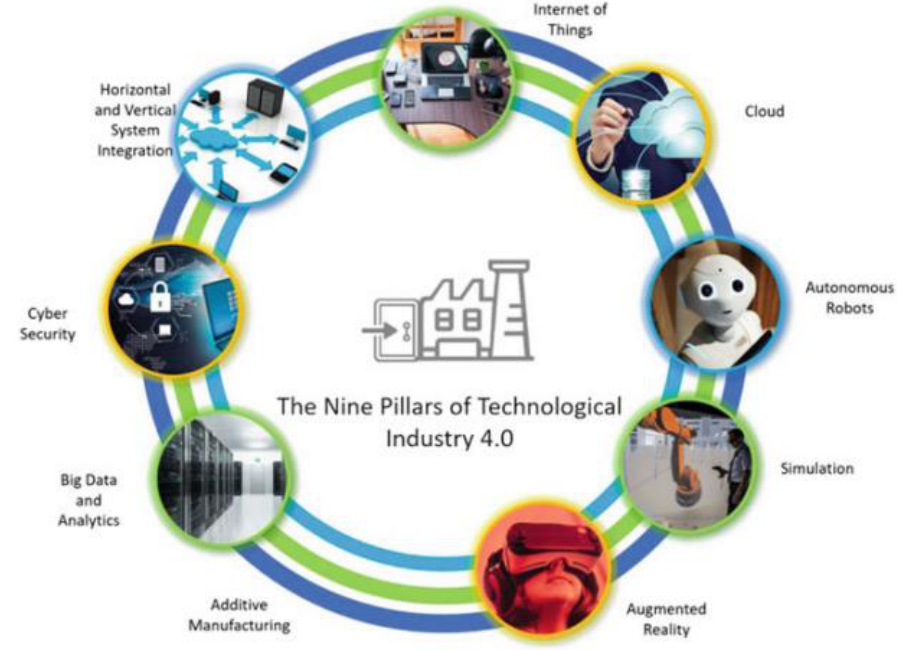
Figure 2. Technologies supporting I4.0 [51].